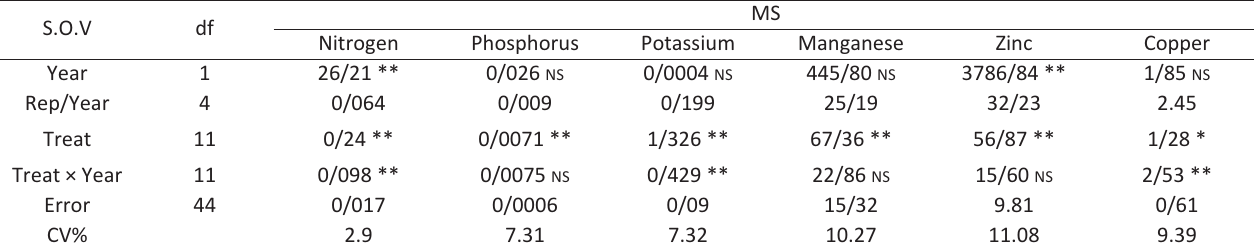
respectively.S.O.V *, **, NS= significant at 5%, 1% and not significant probability levels, Table 4 ­ Results of combined analysis of variance for physiological characteristics in some Iranian garlic clones